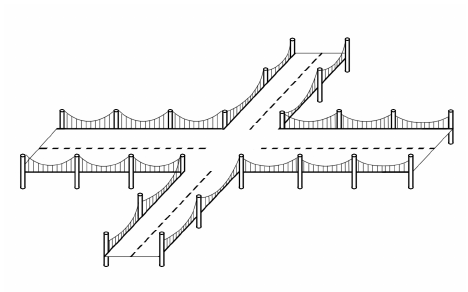
Figure 1. Diagram coupled